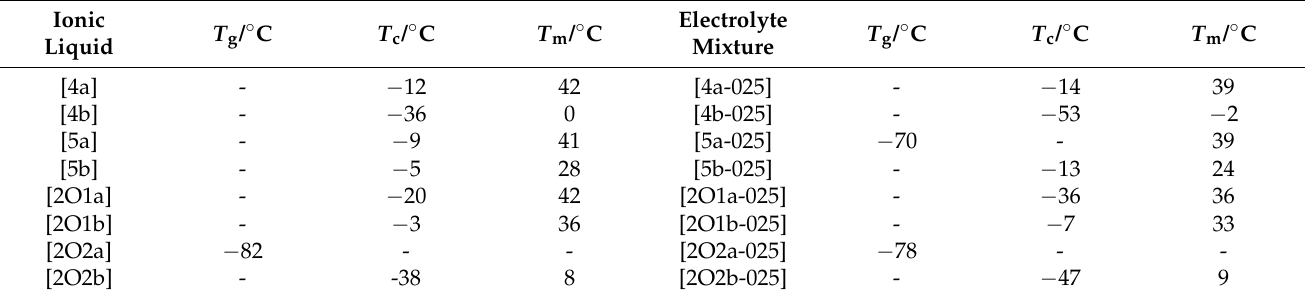
Table 3. Thermal properties of the ionic liquids and ionic liquid binary salt mixtures obtained by DSC measurements at 1 K ∙ min − 1 scanning rate, including the melting point ( T m ), glass transition ( T g ) and crystallization temperature ( T c ). The uncertainty in the temperature is ±1 °C.